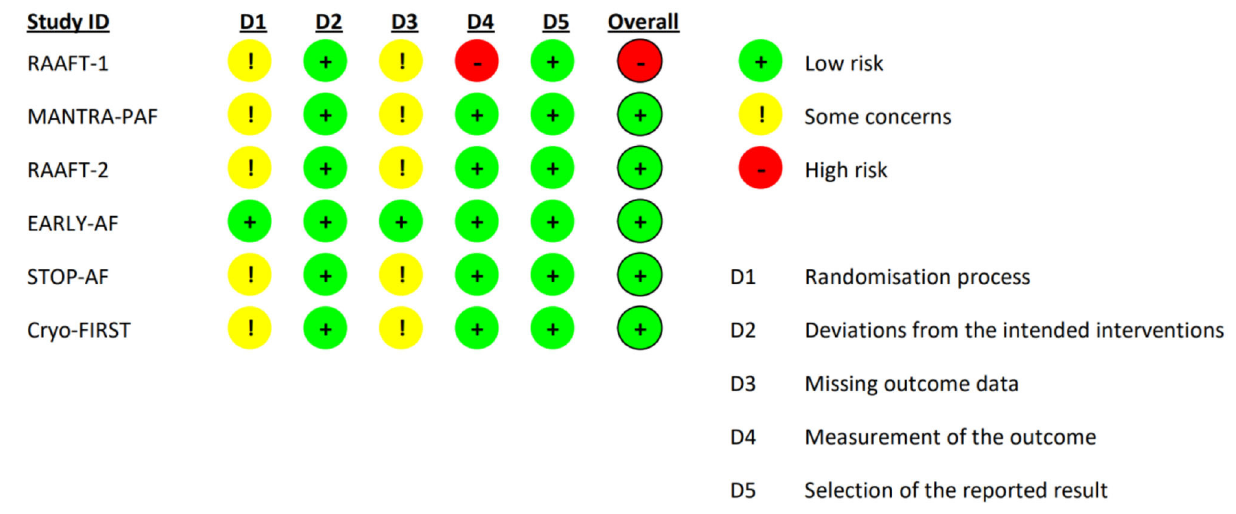
for five studies was low, while RAAFT-1 trial (10) was considered at high risk of bias due to the unblinded outcome